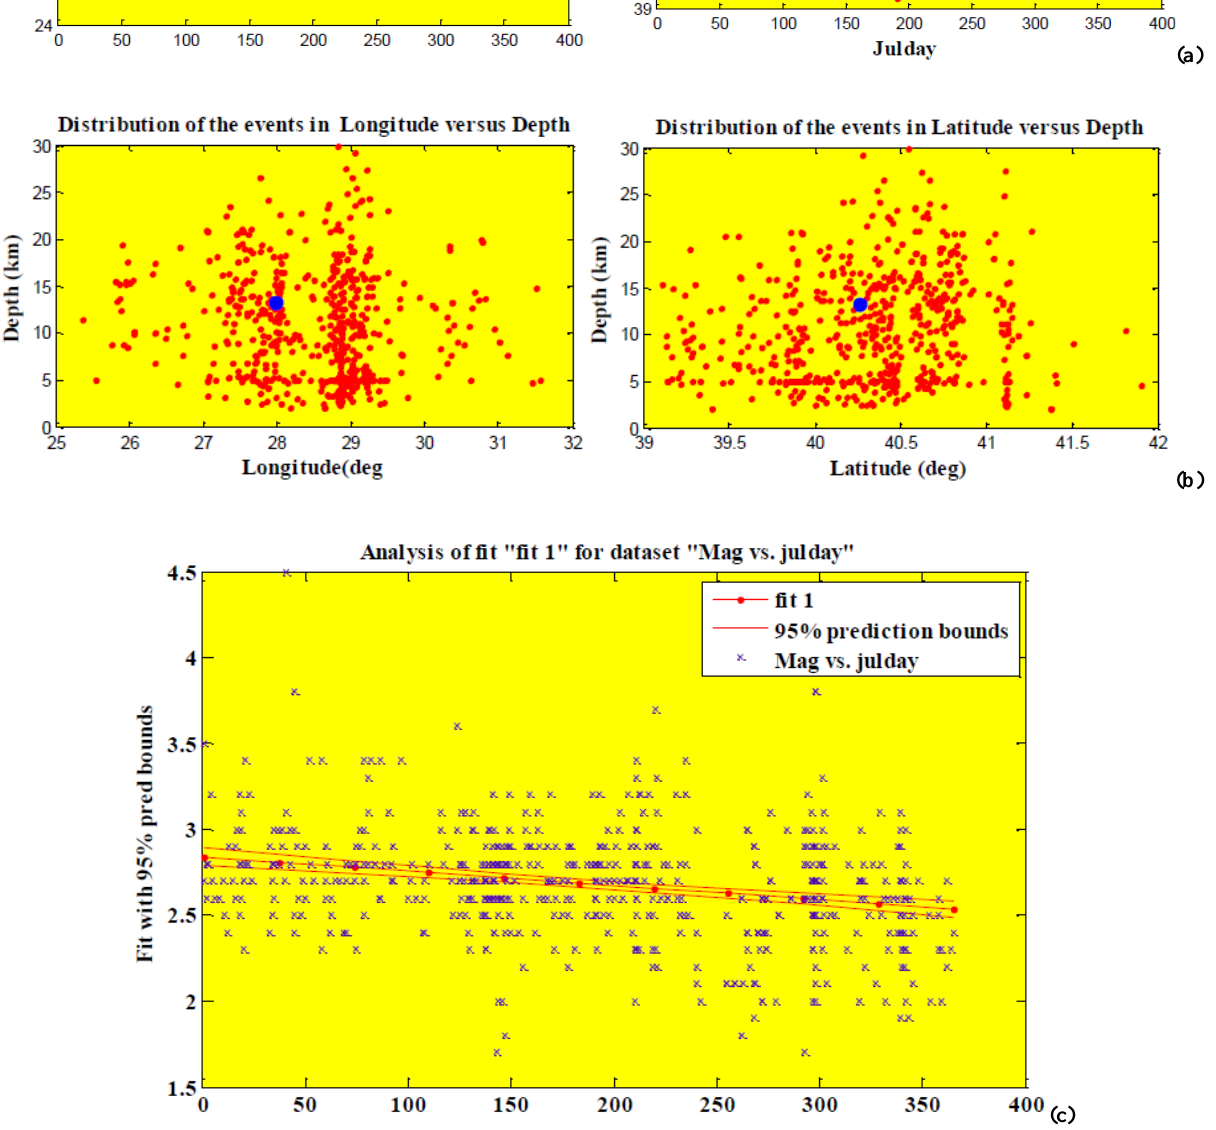
Fig. 7. (a) Distribution of micro events in longitude and latitude versus julday. Micro earthquakes are depicted by red dots. The main event is marked blue. (b) Distribution of micro events in longitude and latitude versus depth. Micro earthquakes and the main even are depicted by red dots and blue circle respectively (c) Analysis of the relationship between magnitude and